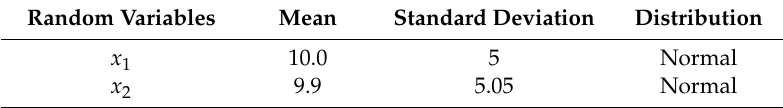
Table 2. Distribution information of the random variables of Example 2.